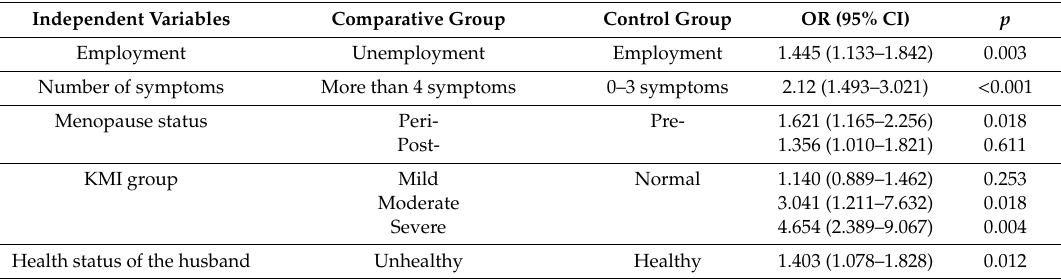
Table 5. The logistic analysis for the factors associated with healthcare seeking among women with menopausal